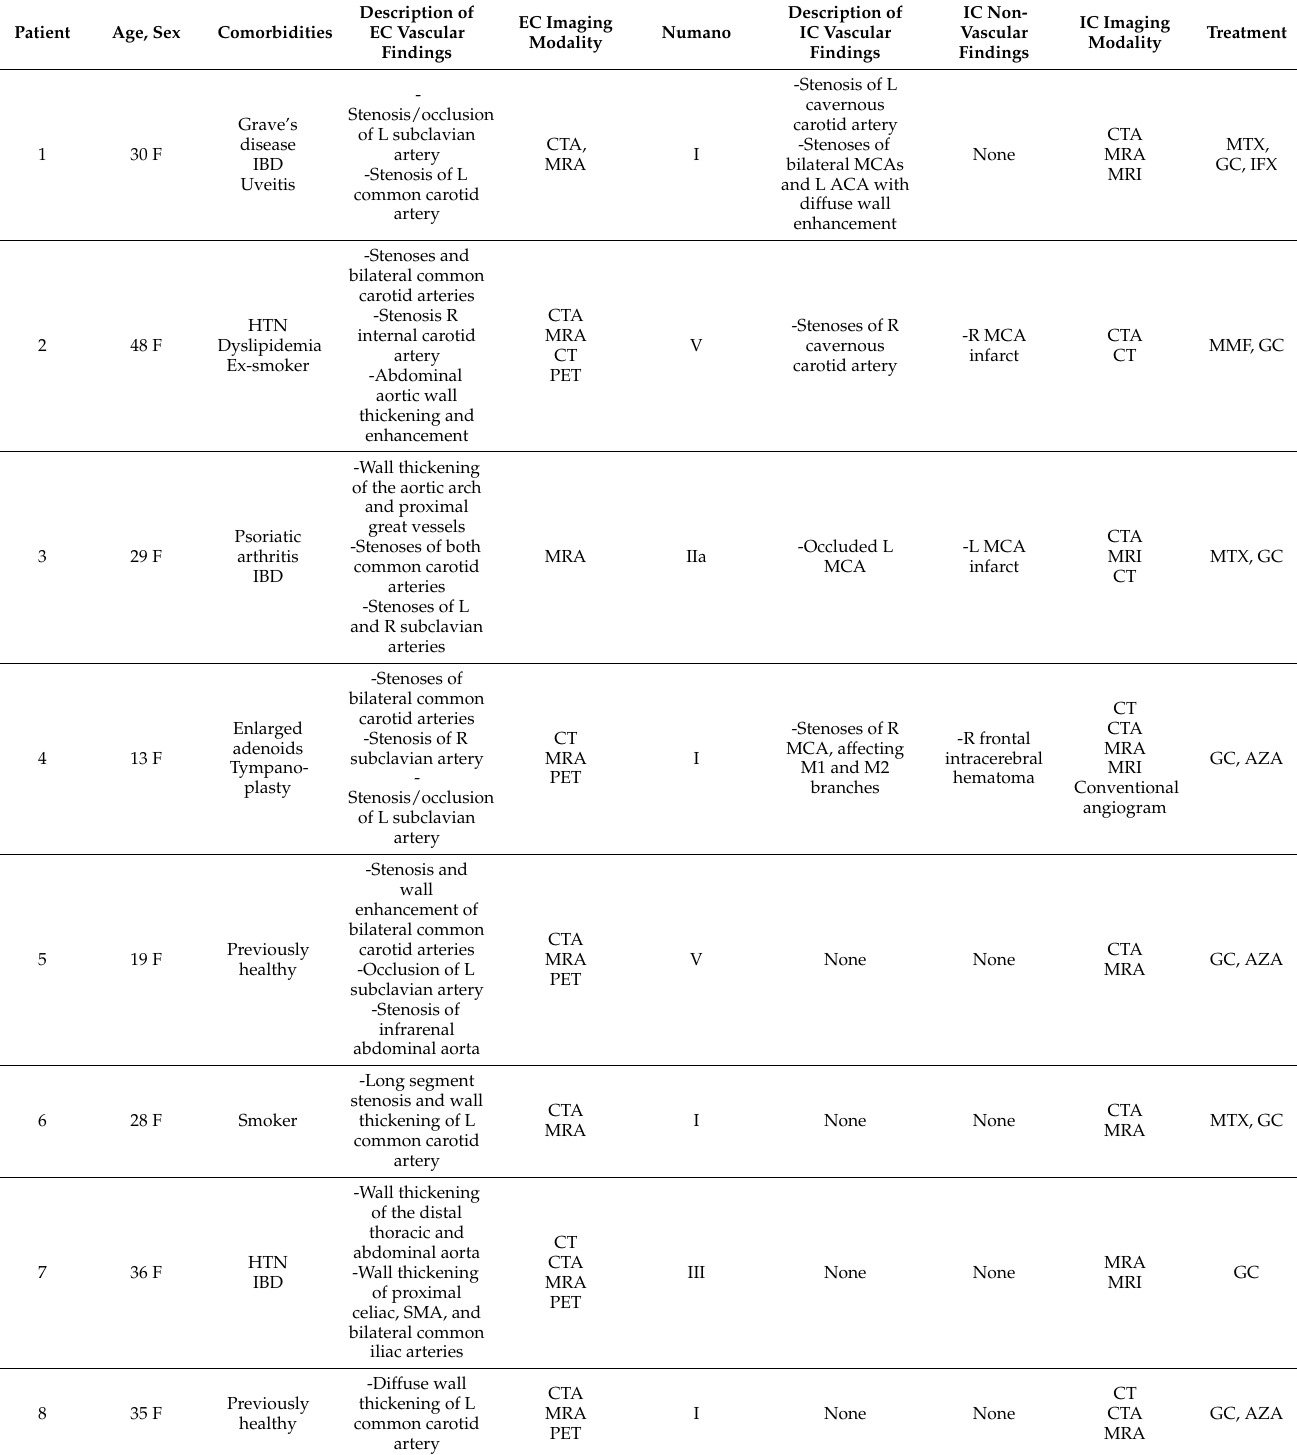
Table 2. Summary of TAK patients with neuroimaging